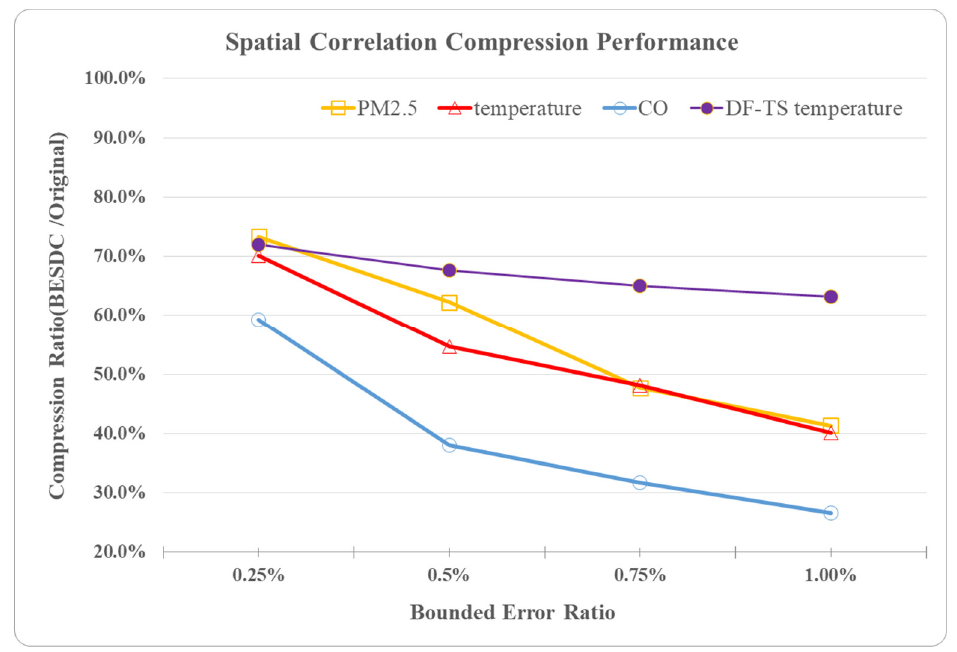
Figure 10. Data compression ratio in SN with “faraway” EDs by spatial correlation compression.